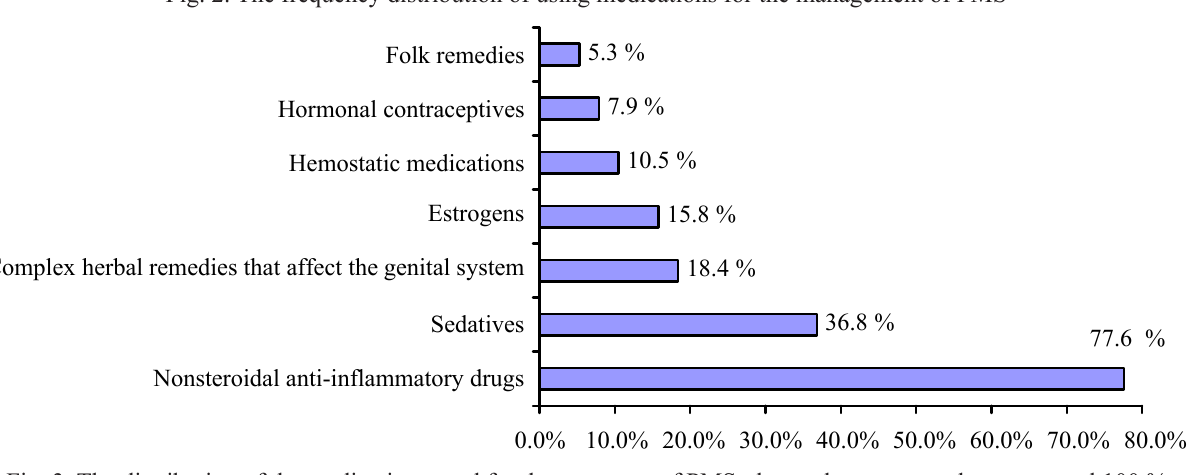
Fig. 2. The frequency distribution of using medications for the management of PMS